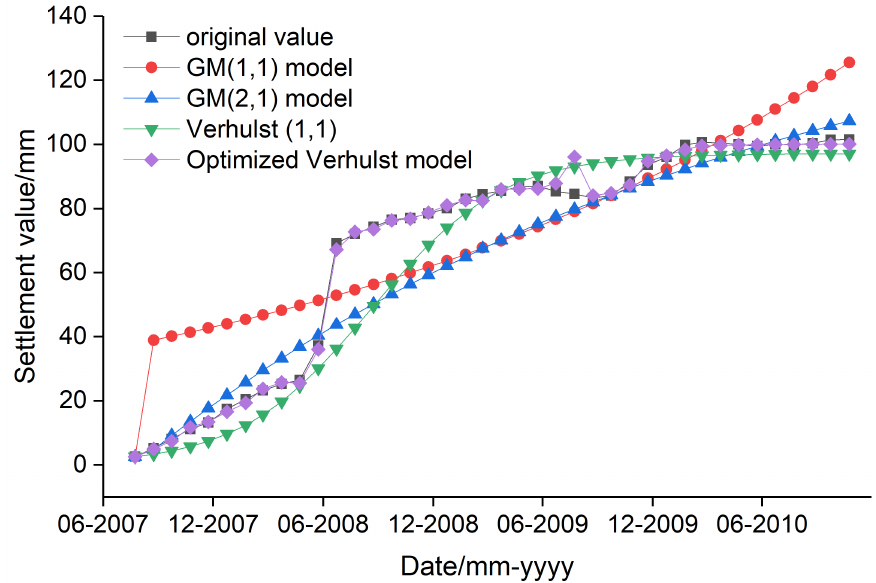
Figure 6. Comparison between measured original values and fitted values of the four models for the monitoring point ZLD-02 from Aug-2007 to